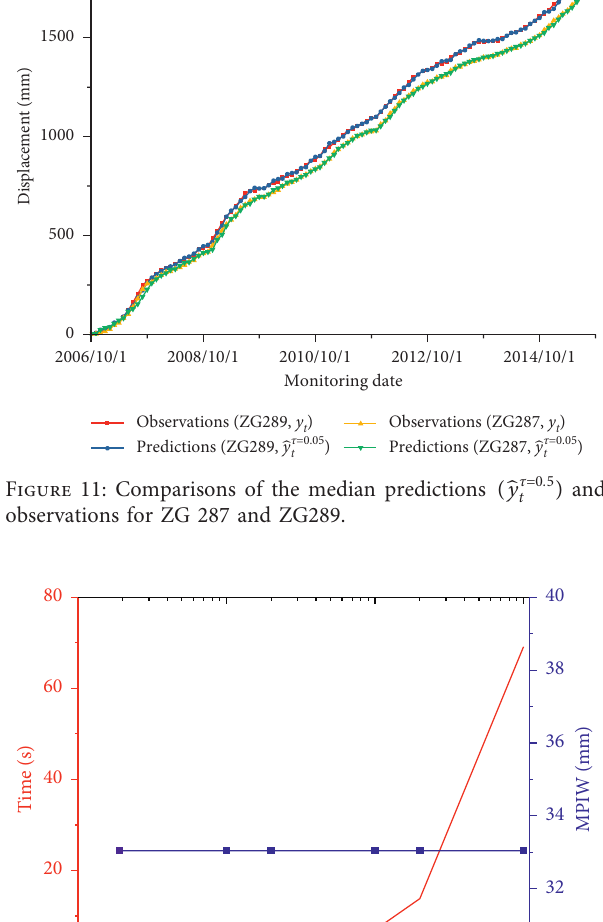
Figure 12: The required computational time and MPIW of con- structed 90% PIs of ZG289 with an increasing number of quantiles in